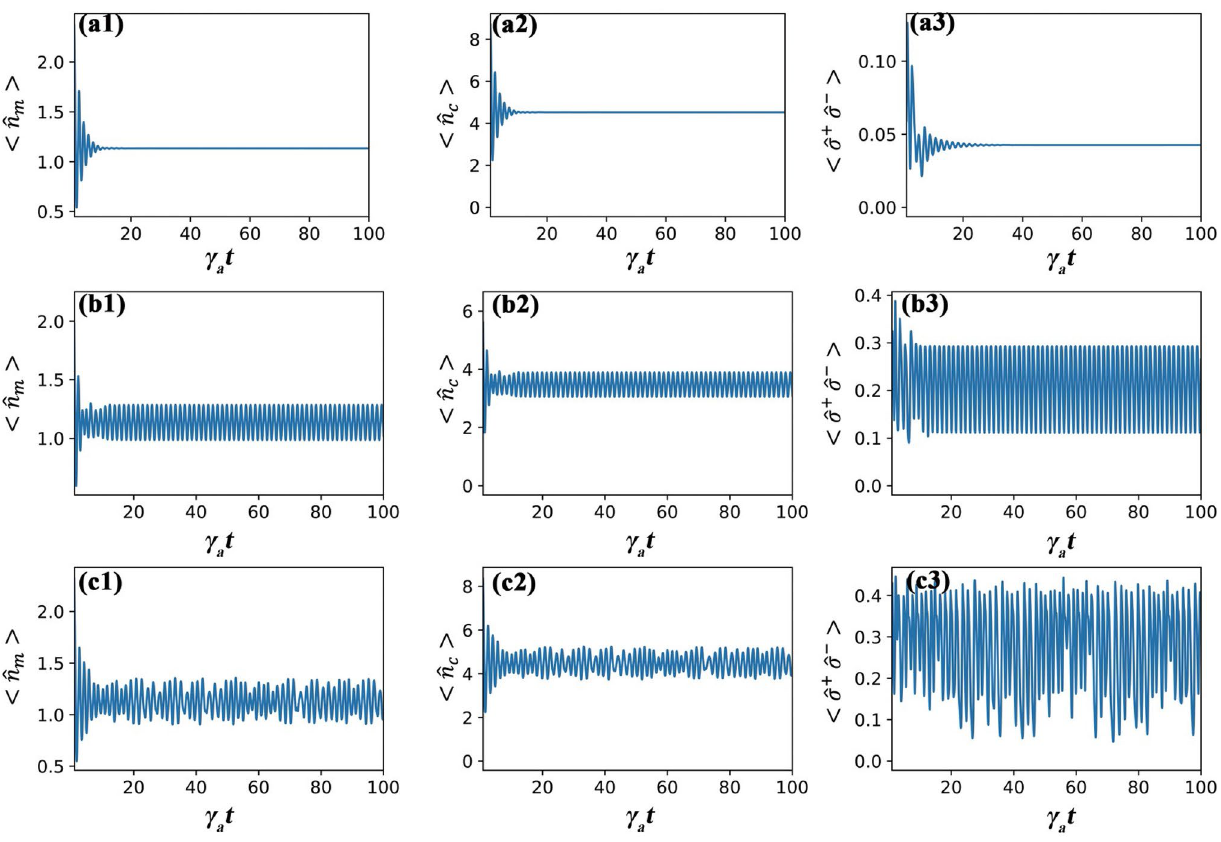
Figure 2. The mean excitation of the membrane mode (first column), the cavity mode (second column) and the atom (third column). The parameters used are γ c /γ a = 0.5, γ m /γ a = 2, η/γ a = 5, V 0 /γ a = 20, V 1 /γ a = 40, ω r /γ a = 1, � c /γ a = − 1, and � a /γ a = − 2. Specific coupling parameters for different phases are given by ( a1 )– ( a3 ) g ac /γ a = 0.5, g mc /γ a = 2; ( b1 )–( b3 ) g ac /γ a = 2, g mc /γ a = 2.5; and ( c1 )–( c3 ) g ac /γ a = 2, g mc /γ a =